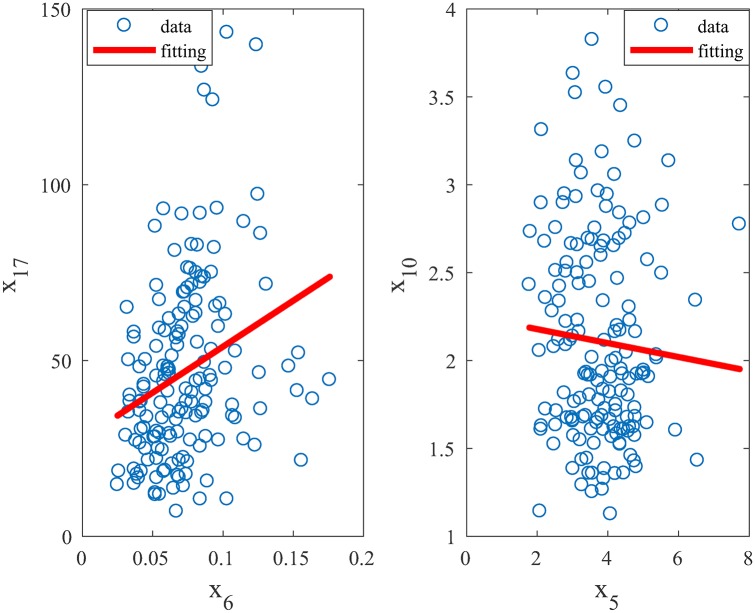
Relations between the measurements of x17 versus x6 and x10 versus x5.